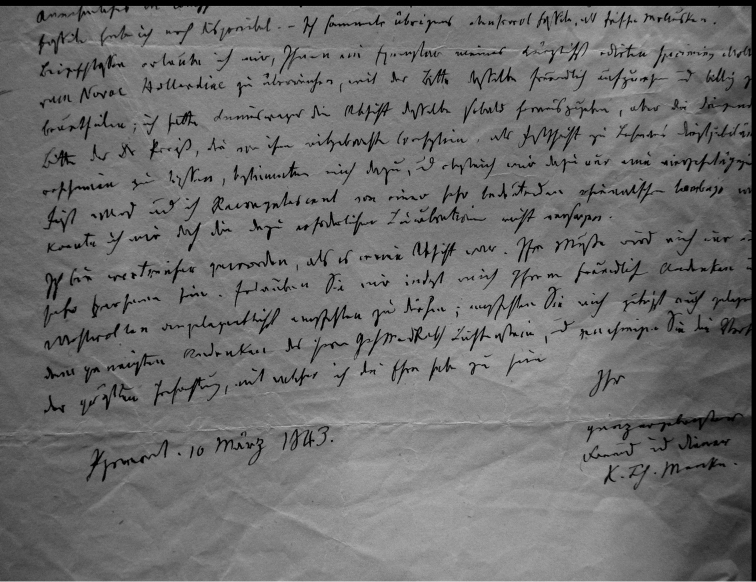
Handwriting of K.Th. Menke. Excerpt from letter d.d. Pyrmont, 10.iii.1843 (19.5 × 25 cm).